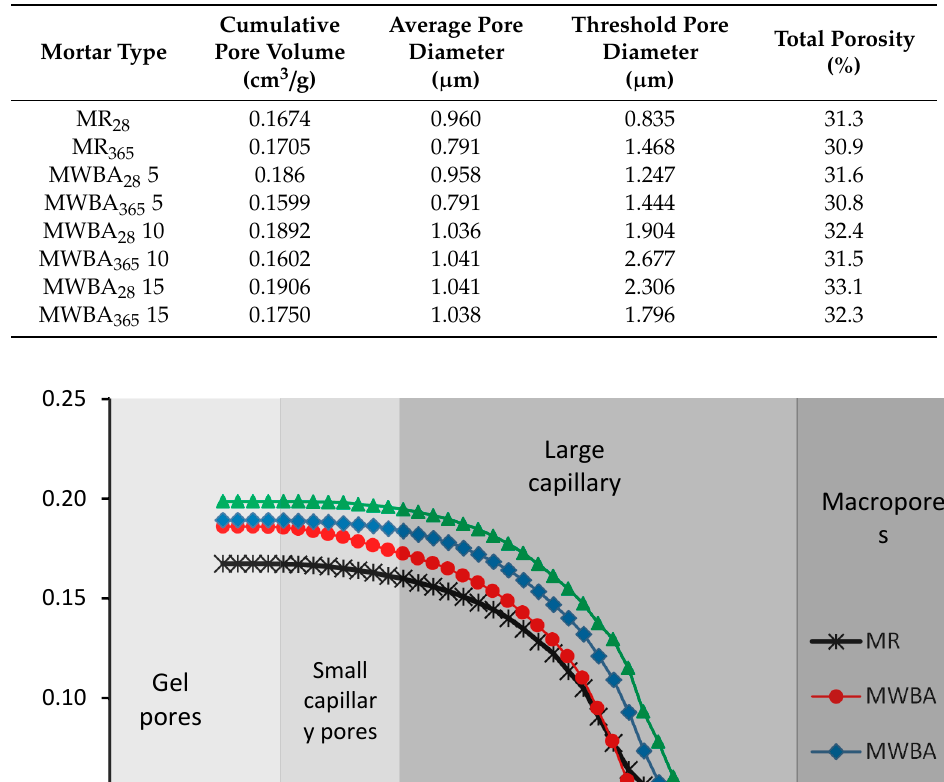
Table 8. Pore size distribution parameters accessed by mercury intrusion porosimetry (MIP).